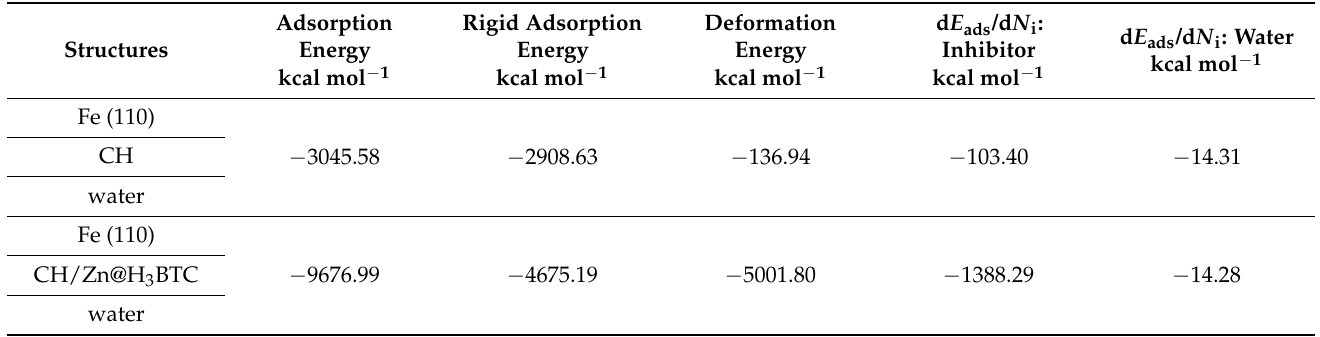
Table 4. Data and descriptors calculated by Mont Carlo (MC) simulation for adsorption of